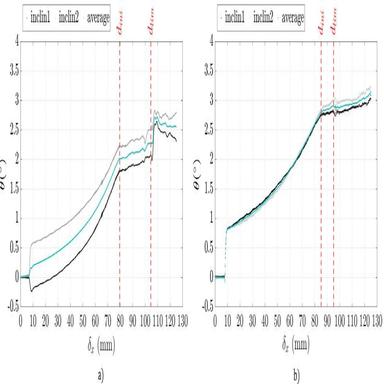
Adherend rotation measured with the inclinometers in (a) rigid adhesive samples (T4-02) and (b) flexible adhesive samples (T7-03).